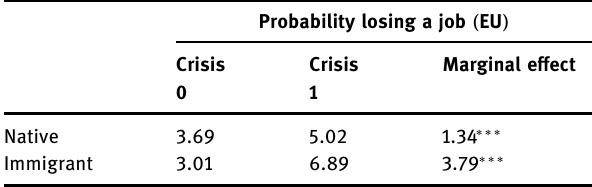
Table A3: Adjusted predictions and marginal e ff ect.